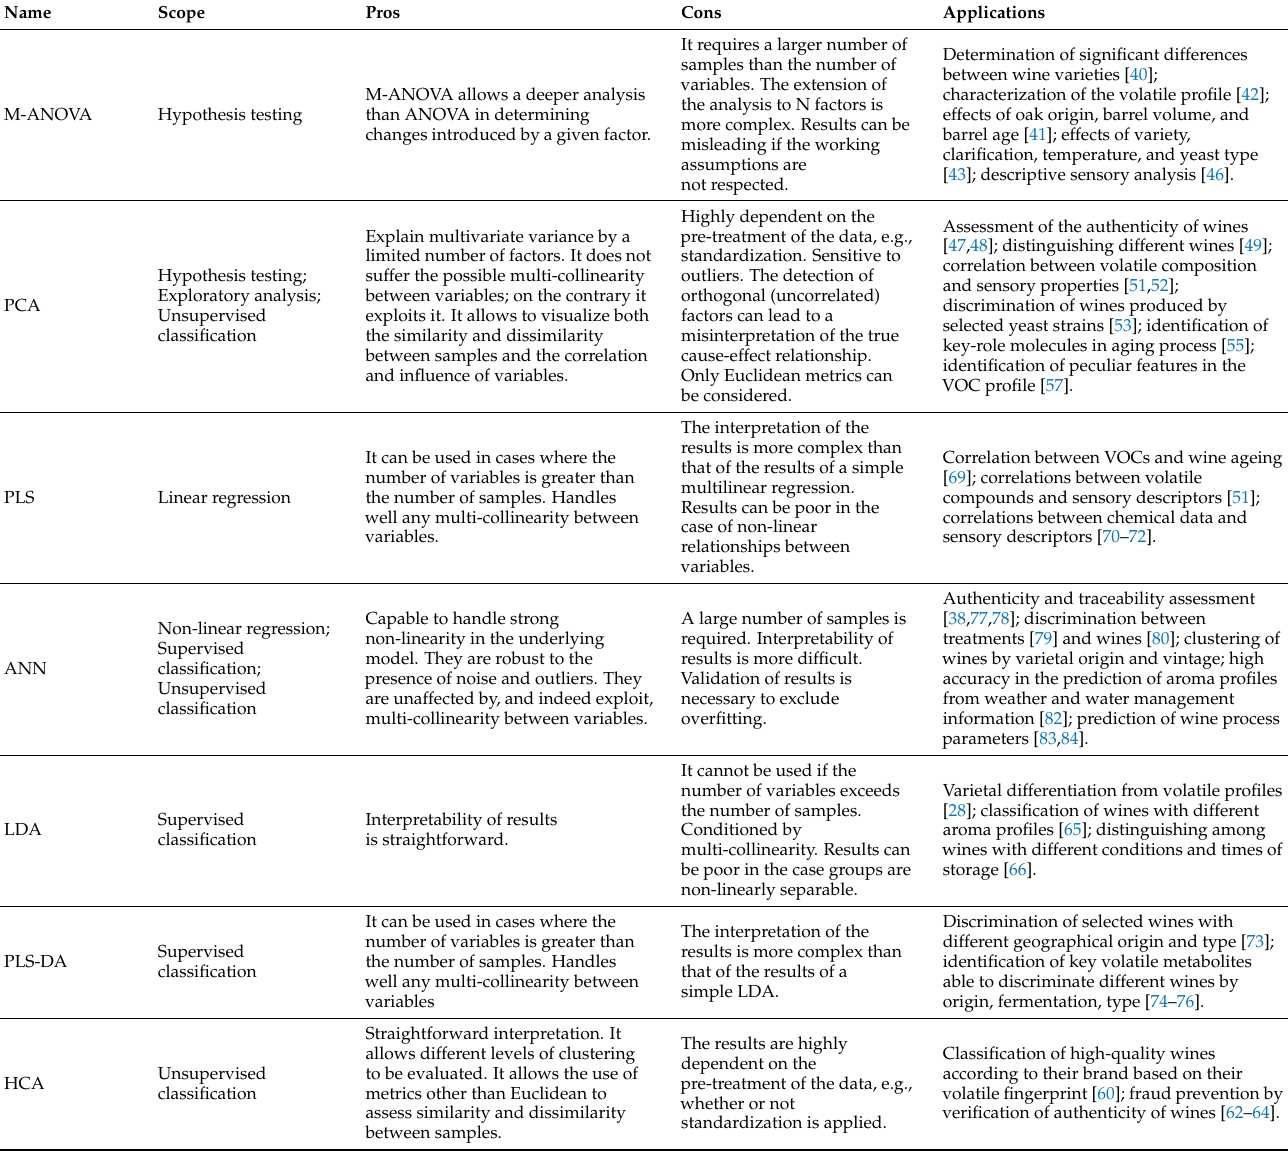
Table 1. Overview of the statistical techniques, pro, cons and applications to HS-SPME/GC-MS